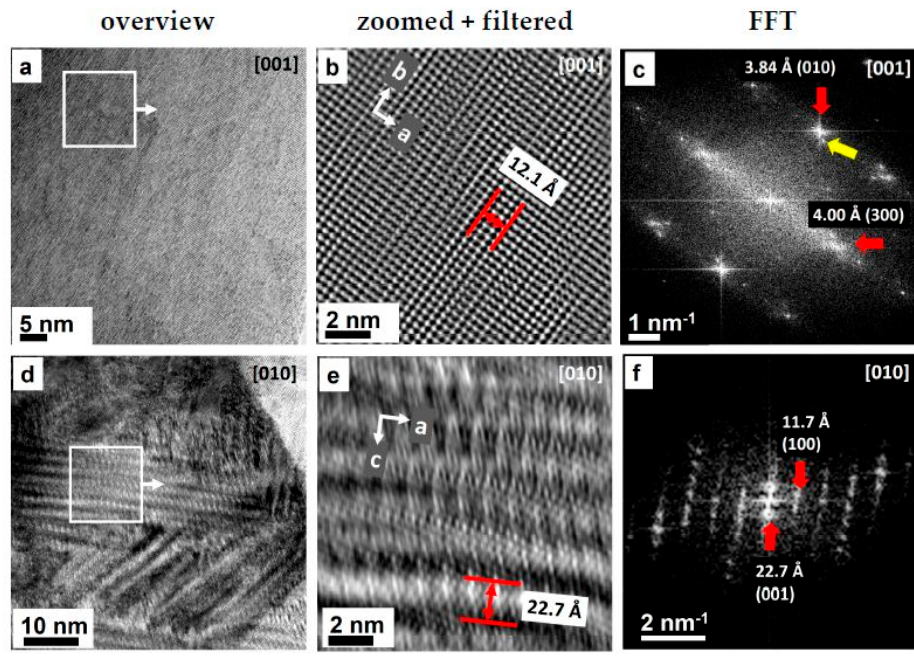
Figure 5. HR-TEM images of SPS-prepared WO 2.90 material along ( a – c ) [001] and ( d – f ) [010]. ( a ) Good ordering is found for the zone [001]; ( b ) The Fourier-filtered micrograph reveals a lattice with long-range variations; ( c ) Yellow-marked reflections in the corresponding FFT image indicate a superstructure; ( d ) CS planes are found for the [010] zone, however massive disorder is observed with deviations of CS plane orientations of about 44 ◦ ; ( e ) Zooming and filtering reveals short-range order along [001]; ( f ) FFT with broadened and diffuse (001) reflection confirms disturbance of the atomic arrangement along [001].